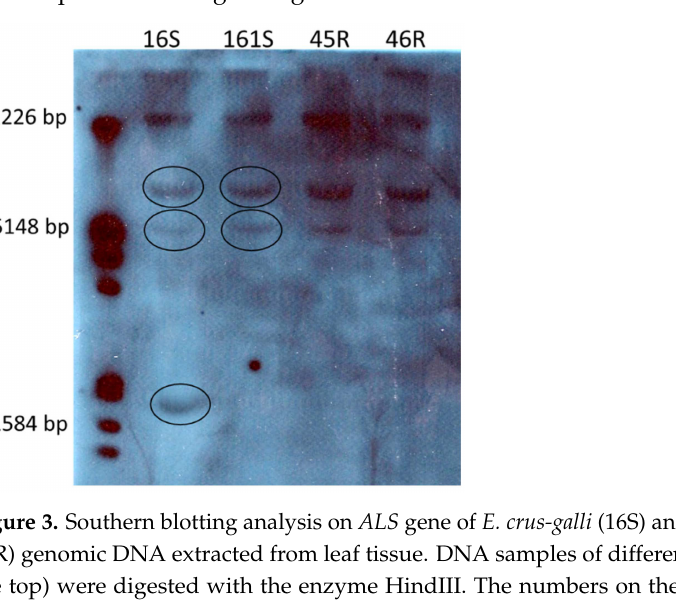
Figure 2. Results of CAPS-rbcL molecular marker for a selection of samples tested: plants belonging to “white” species, E. oryzicola (161S, 44R, 45R and 46R), show the two digested bands at 134 and 87 bp, whereas plants belonging to “red” species, E. crus-galli (16S, 95R and 100R) show a single band.